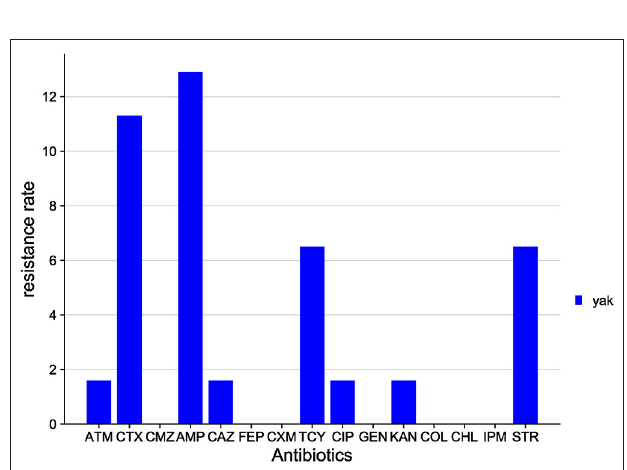
FIGURE 7 | Distribution of antibiotic resistant phenotypes in E. coli from Sichuan.